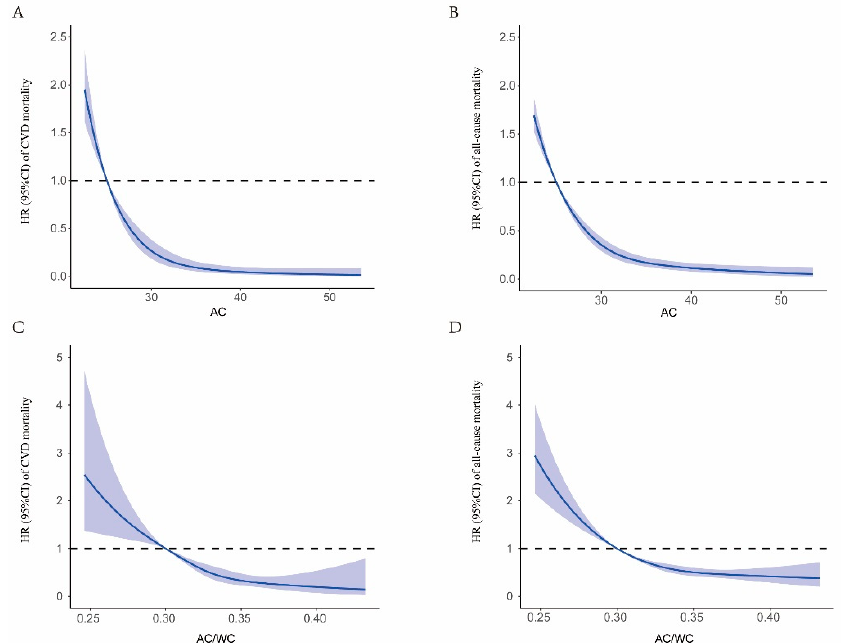
Figure 3. Dose-response association between AC and CVD mortality risk ( A ), AC and all-cause mortality risk ( B ), AC/WC and CVD mortality risk ( C ), AC/WC all-cause mortality risk ( D ). Associations were examined by multivariable Cox regression models based on restricted cubic splines. The solid line represents estimates of hazard ratios and the dashed line represents 95% CIs. HRs were adjusted for age, gender, race/ethnicity, education, alcohol drinking status, smoking status, BMI, total cholesterol, high-density lipoprotein cholesterol, carbohydrate intake, dietary fiber intake, fasting glucose, history of hypertension, and history of dyslipidemia, history of cancer, self-reported health.